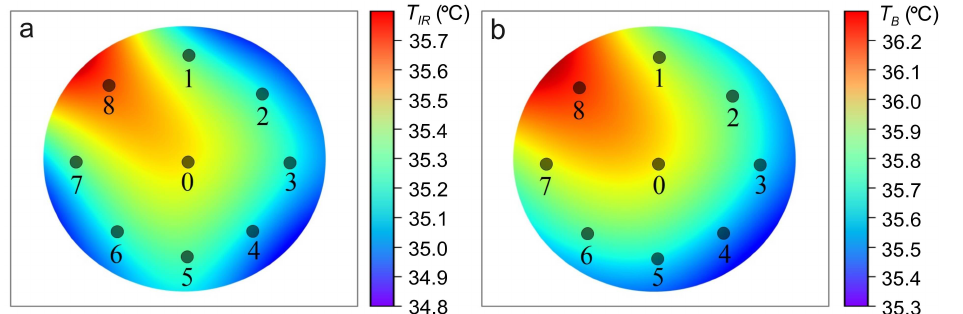
Figure 21. The infrared ( T IR , ( a )) and brightness ( T B , ( b )) temperature distributions from the simula- tions show a characteristic bell-shaped appearance.